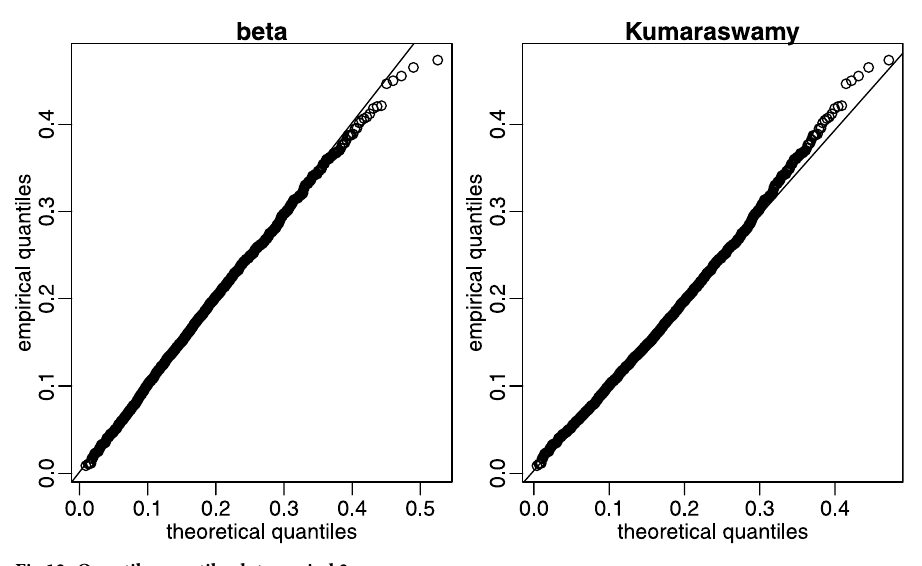
Fig 12. Quantile-quantile plots, period